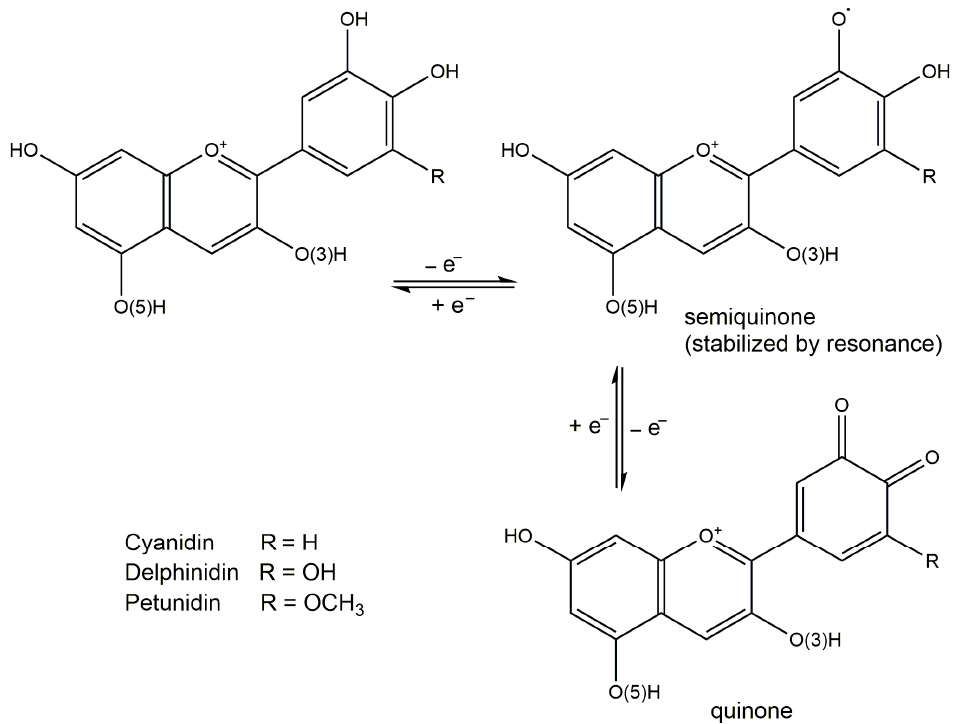
Figure 3. Two-electron oxidation of anthocyanins which contain the catechol moiety in their struc-